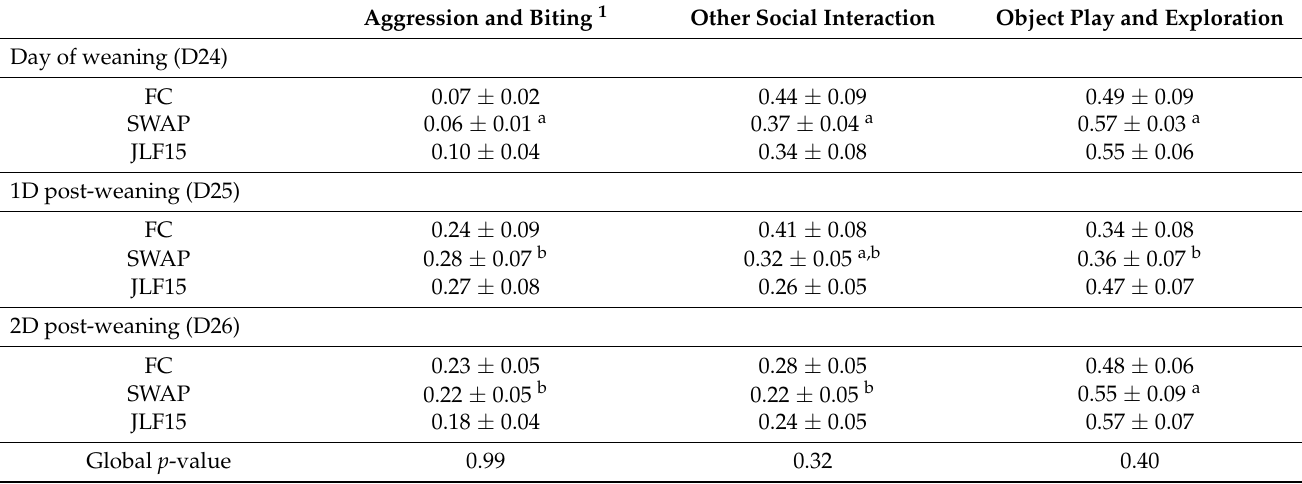
Table 3. Proportion (number of behavior/total active behaviors) of active behaviors in piglets (mean ± SE) in the post-weaning period in three farrowing systems (FC, n = 4: conventional farrowing crate; SWAP, n = 6, and JLF15, n = 6: farrowing pens with temporary crating). Values with a different superscript ( a , b ) correspond to a significant difference ( p ≤ 0.05) between observation days in the same behavior category and farrowing system. n indicates the number of nursery pens. Aggression and Biting 1 Other Social Interaction Object Play and